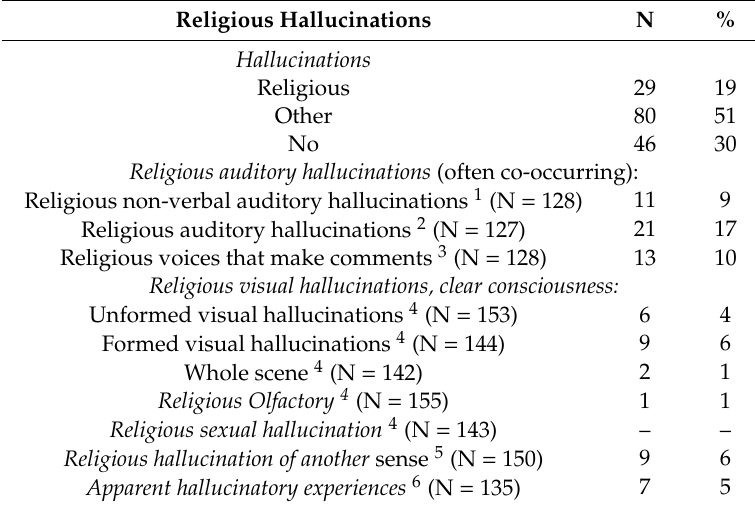
Table 2. Symptoms with religious content, religious hallucinations (RHs) (N =